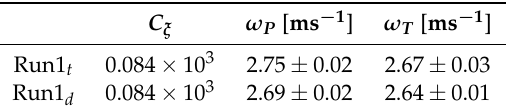
Table 4. Exponential growth rates (in ms − 1 ) for both poloidal ( ω P ) and toroidal ( ω T ) components of the magnetic filed for Run1. The subscript t ( d ) is for the purely toroidal (dipolar) initial configuration of the magnetic